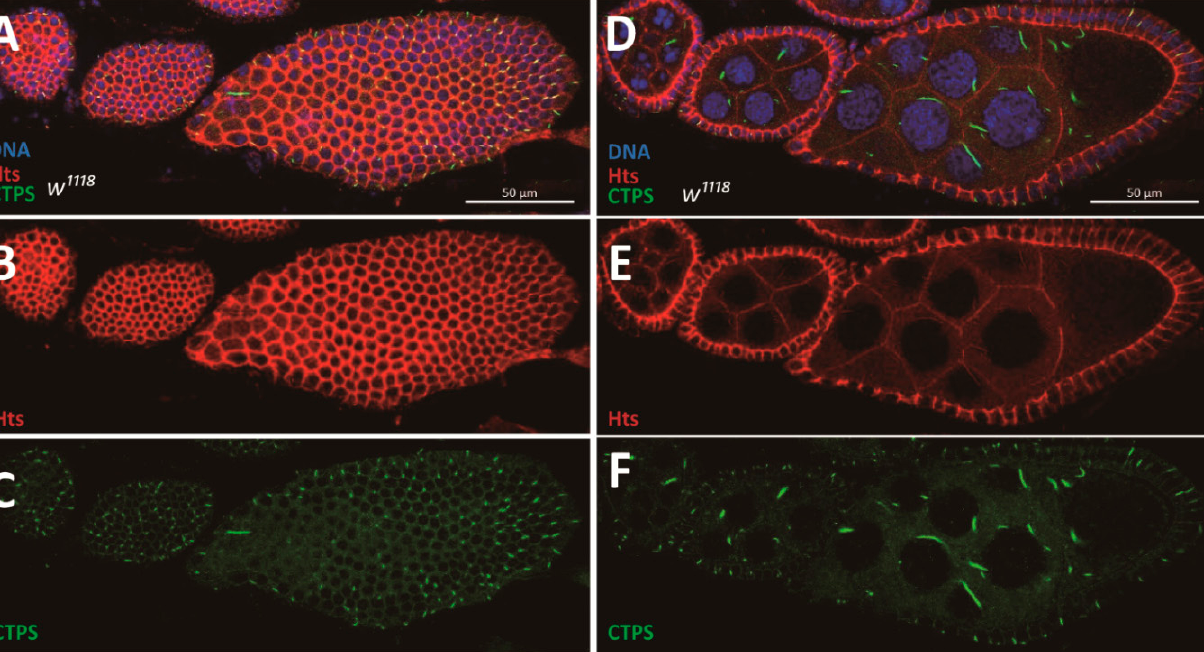
Figure 1. Follicle cells maintain monolayer during Drosophila oogenesis. ( A – C ) Surface view of a wild-type ovariole containing different stages of egg chambers. The ovariole is subjected to immunofluorescence analysis with antibodies against CTPS (green) and Hts (red, labelling cell membranes). DNA is labelled by Hoechst 33342 (blue). ( A ) Cytoophidia are distributed almost at different stages of each follicle cell. ( B ) The boundaies of follicle epithelia are displayed by a single projection of Hts staining. ( C ) CTPS staining shows the distribution of cytoophidia on the surface of egg chambers. ( D – F ) Side view of the same ovariole in ( A – C ). ( D ) Monolayer follicle cells envelop germline cells. ( E ) A single projection of Hts staining shows the monolayer structure of follicle epithelia. ( F ) CTPS staining shows the distribution of cytoophidia in follicle cells and germline cells. Scale bars, 50 µ